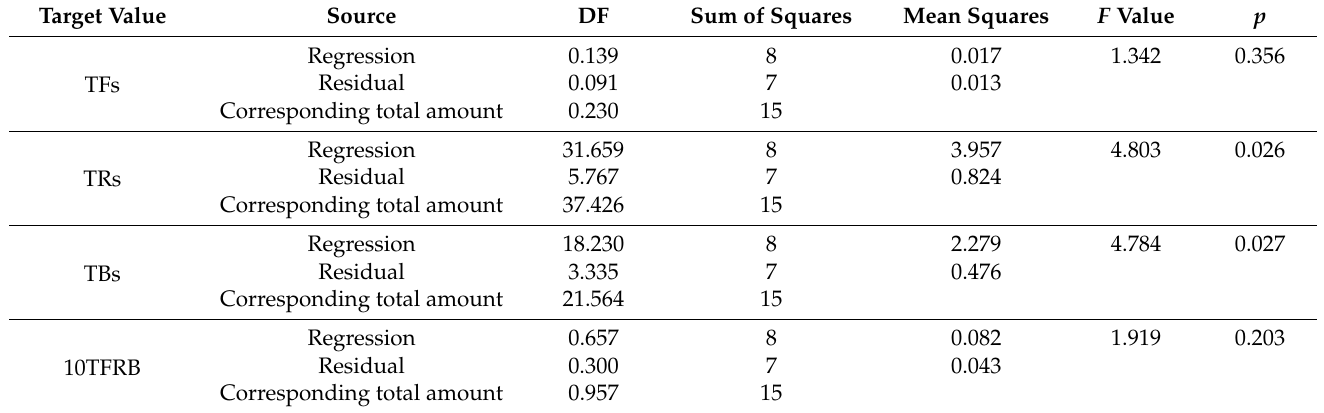
Table 1. Regression analysis of the TFs, TRs, TBs, and 10TFRB values as target values.